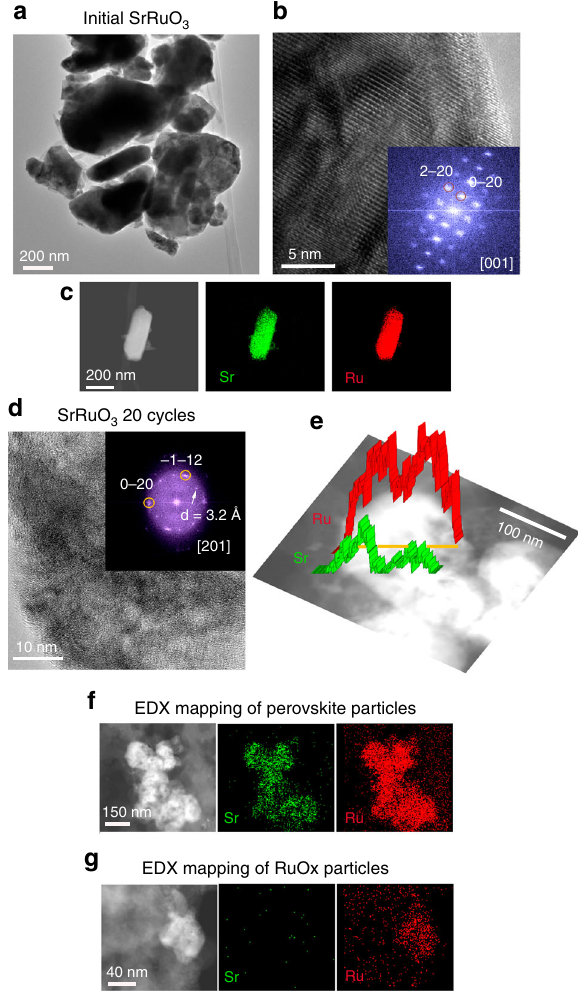
Fig. 3 Evolution of SrRuO 3 during OER. a TEM, b HRTEM/DDP and c STEM- EDX mapping of SrRuO 3 perovskite before the OER reaction. d HRTEM/ DDP, e STEM-HAADF micrographs with the line scans, f STEM-EDX mappings of SrRuO 3 after 20 OER cycles, g STEM-EDX mapping of a RuO x particle segregated after 20 OER